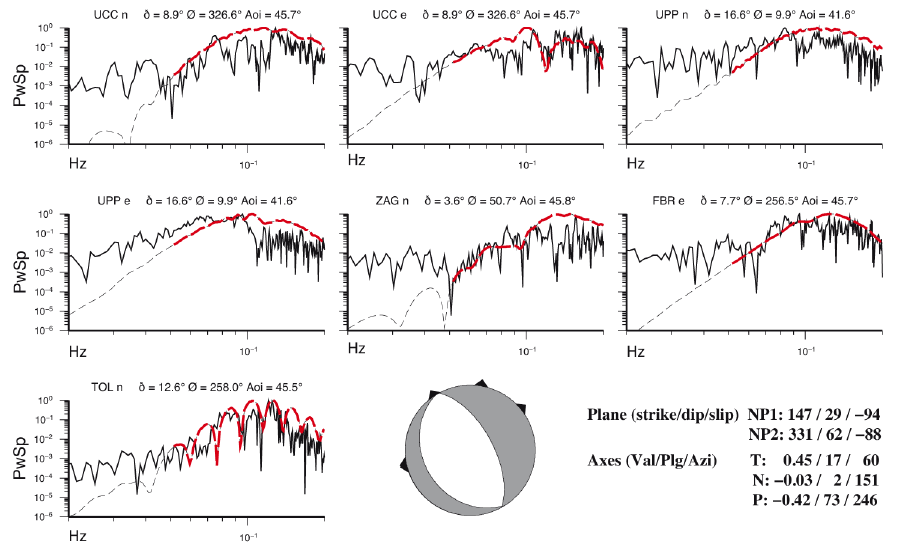
Figure 8. Power spectra amplitudes of the stations used for MT inversion for the 1917 Monterchi earthquake. Station codes, seismogram directions (E-W/N-S) and synthetic (dark and dash lines) and observed (gray line) power spectra amplitude are shown. Distance ( D ) azimuth ( U -) and take off angle (Aoi) between epicenter and station are also